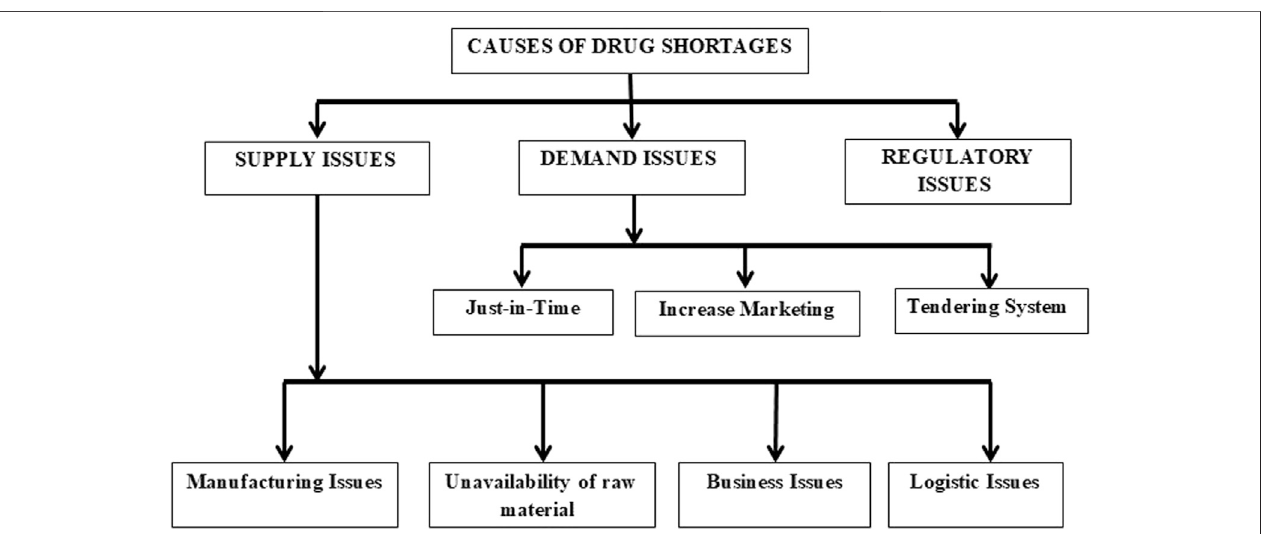
FIGURE 2 | Causes of drug